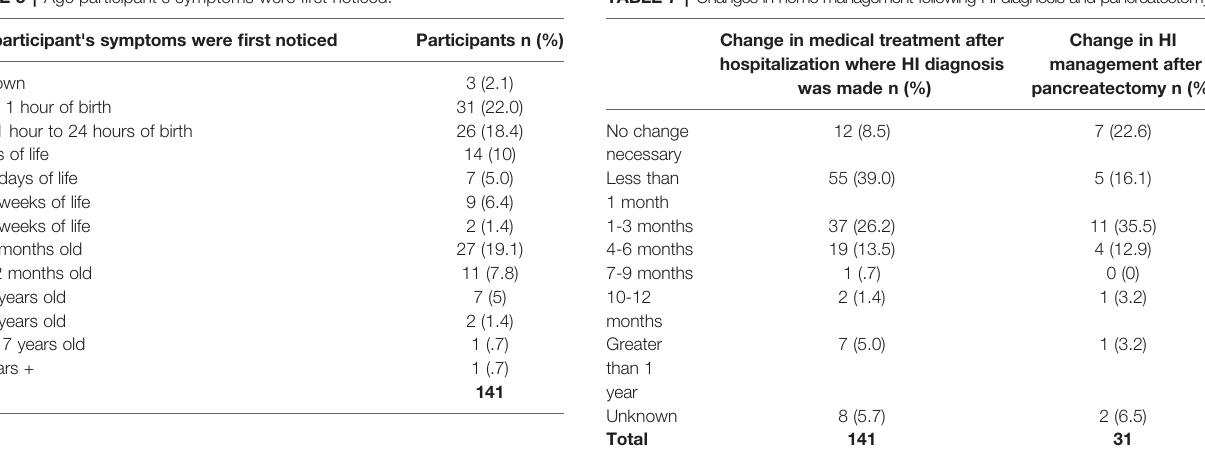
TABLE 6 | Identi fi ed signs of hypoglycemia before leaving the birthing facility. Respondent reported known hypoglycemia risk factors identi fi ed prior to or shortly after delivery (before leaving the